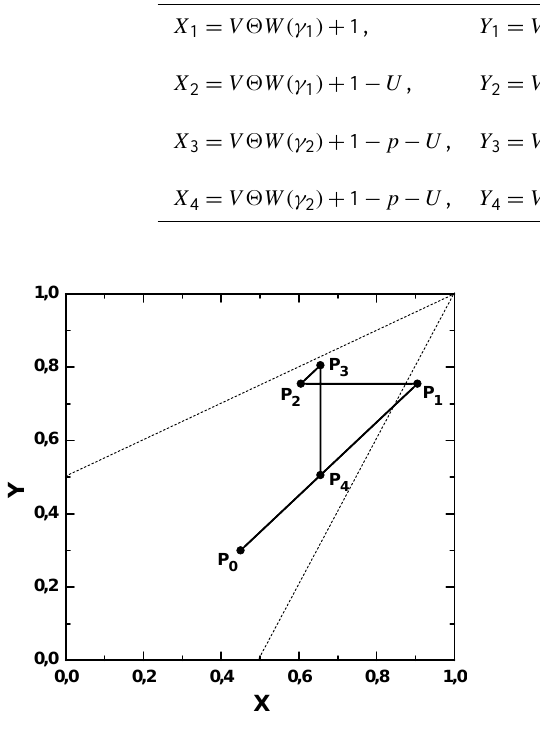
Fig. 3. Orbit with initial point P 0 = ( 0 . 45 , 0 . 3 , − 0 . 15 ) and with α = 1, (cid:15) = 0 . 7, V 2 =